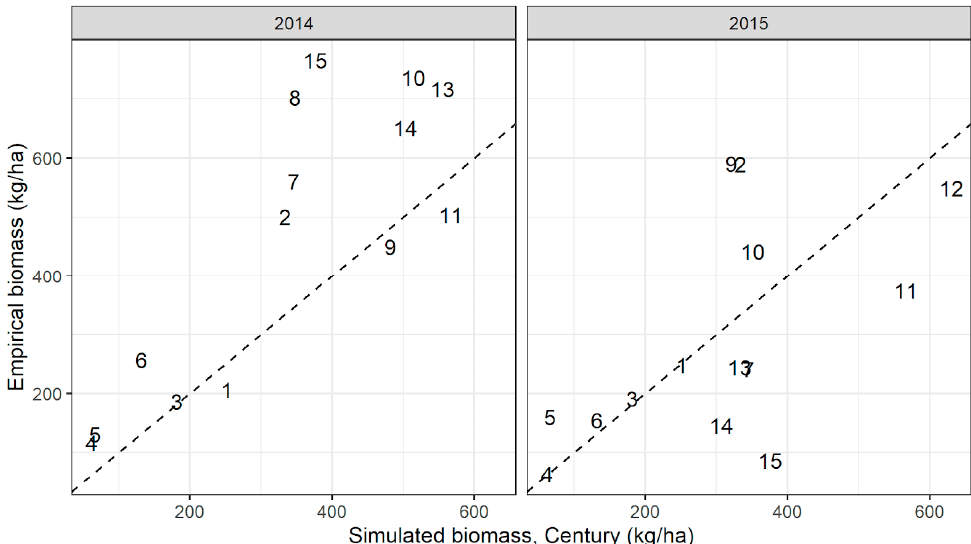
Figure A10. Biomass simulated by Century when driven by long-term average precipitation from Worldclim at the site centroid, compared to mean empirical biomass within sites. Simulated biomass shown here was taken from the month when field data were collected at each site (as opposed to Figure A7, which shows peak biomass from Century). Grazing pressure included in Century simulations was year-round removal of 3% of standing biomass.